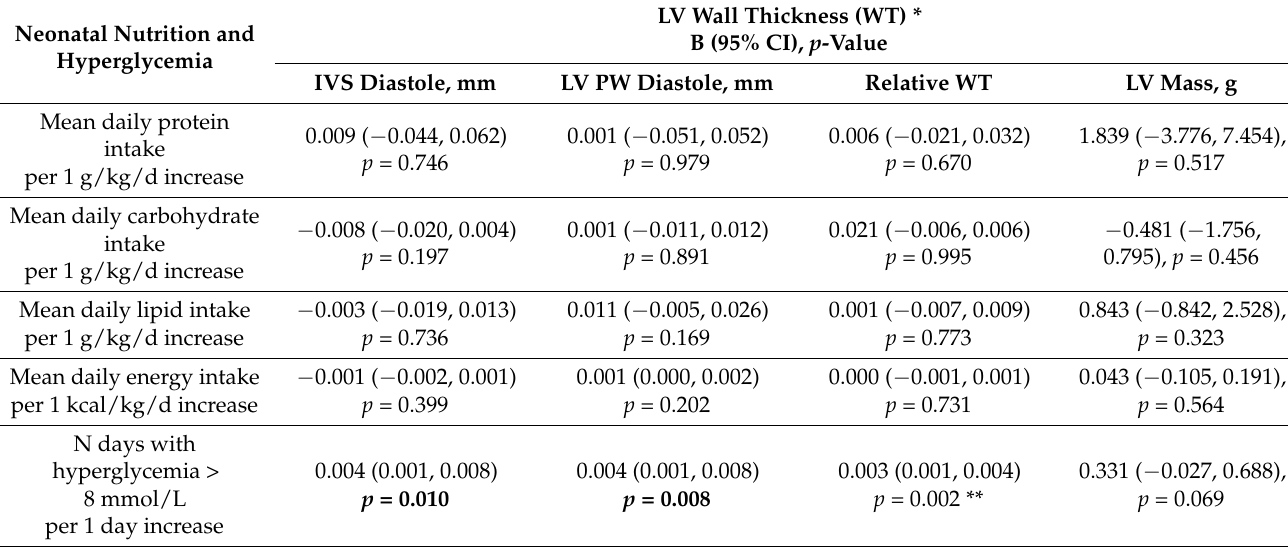
Table 6. Associations between macronutrient and energy intakes and hyperglycemia during the neonatal period with left ventricular wall thickness at 6.5 years of age in children born extremely